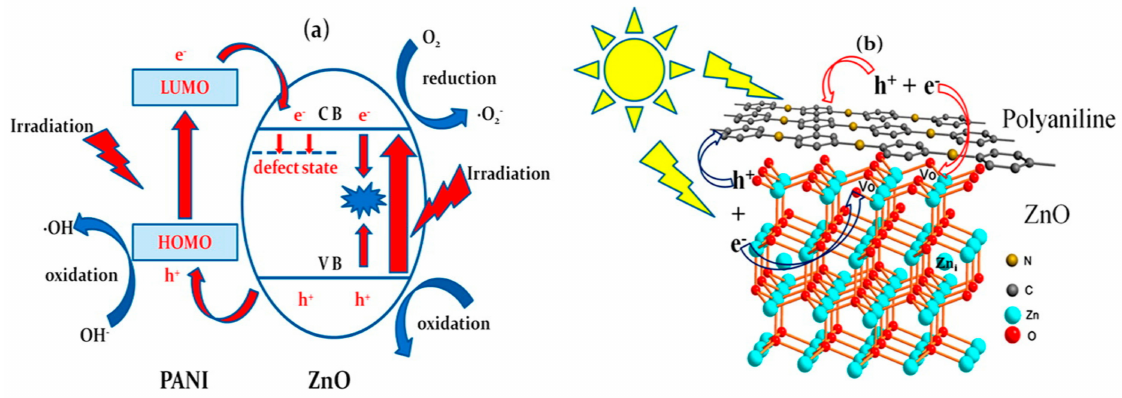
Figure 17. Proposed photocatalytic mechanism according to the band alignment ( a ). Atomic schematic diagram, illustrating the synergistic e ff ect between defects and polyaniline (PANI) ( b ). Adapted and reprinted with permission from [285], Copyright (2014) American Chemical